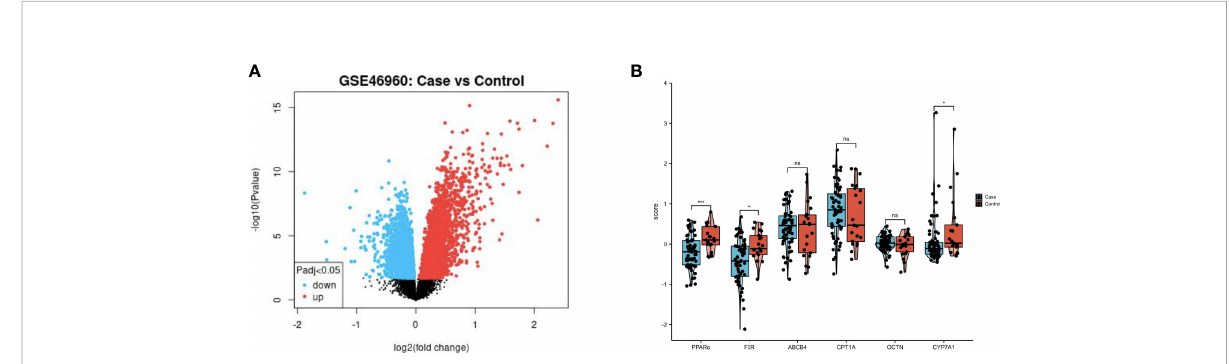
FIGURE 1 PPAR and FXR were downregulated in the liver of patient with BA. (A) Volcano plot of the GSE46960 dataset (BA patients: n=64, non-BA patients with intrahepatic cholestasis: n=14, and normal liver patients: n=7). Red and blue points indicate up- and downregulated genes in BA group respectively. (B) Comparison of gene expression levels between two clusters. ns, not signi fi cant, *P<0.05, **P<0.01,